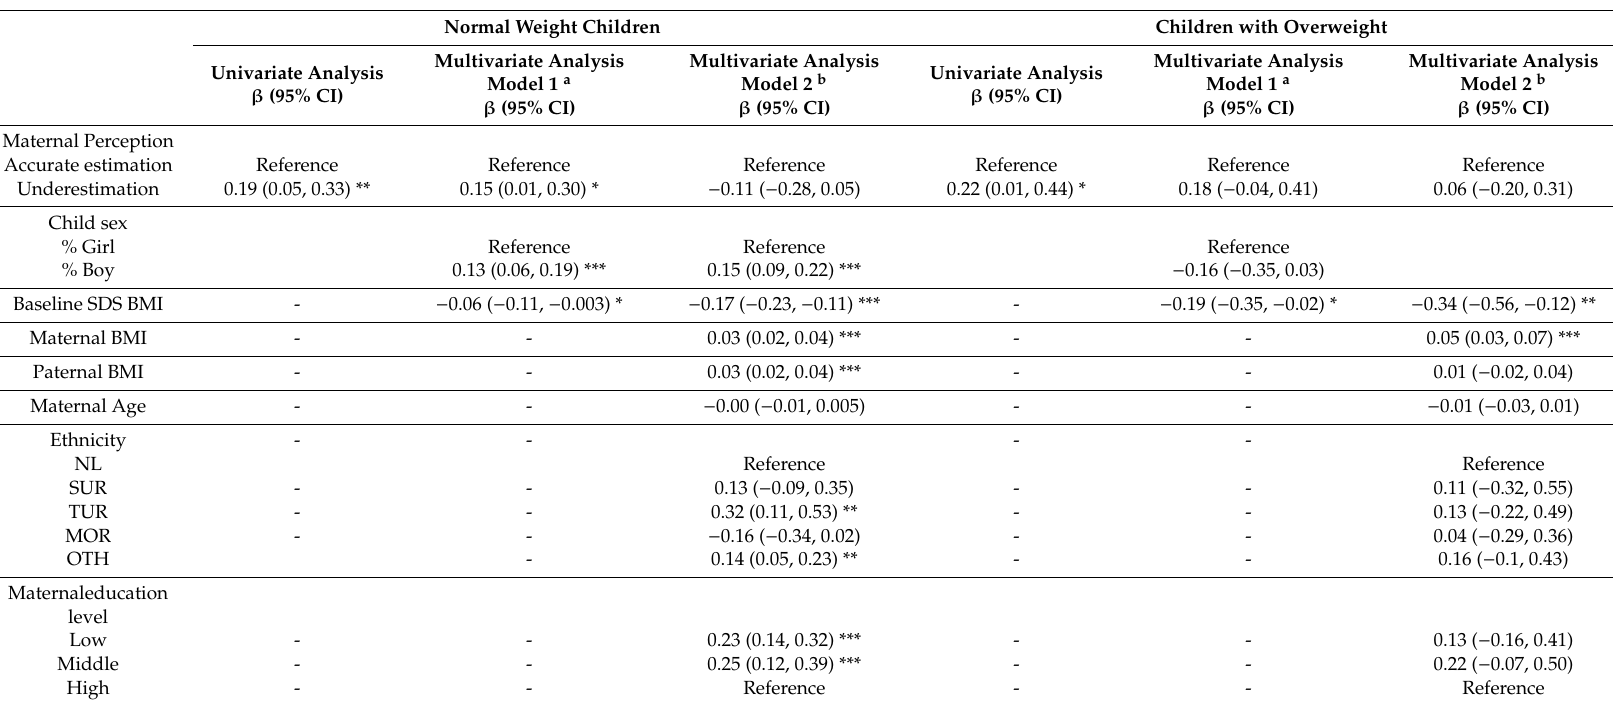
Table 2. Univariate and Multivariate associations between ‘maternal perception of child’s weight’ and ‘child’s weight development’ (delta SDS BMI) between 5 / 6 and 11 / 12 for children with normal weight at age 5 / 6 ( n = 1982) and overweight ( n =